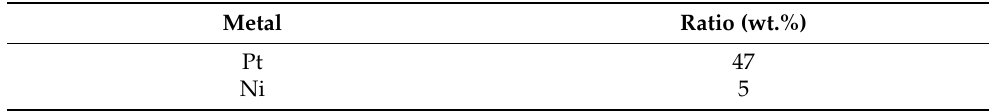
Table 2. Metal composition of PtNi/C from ICP.